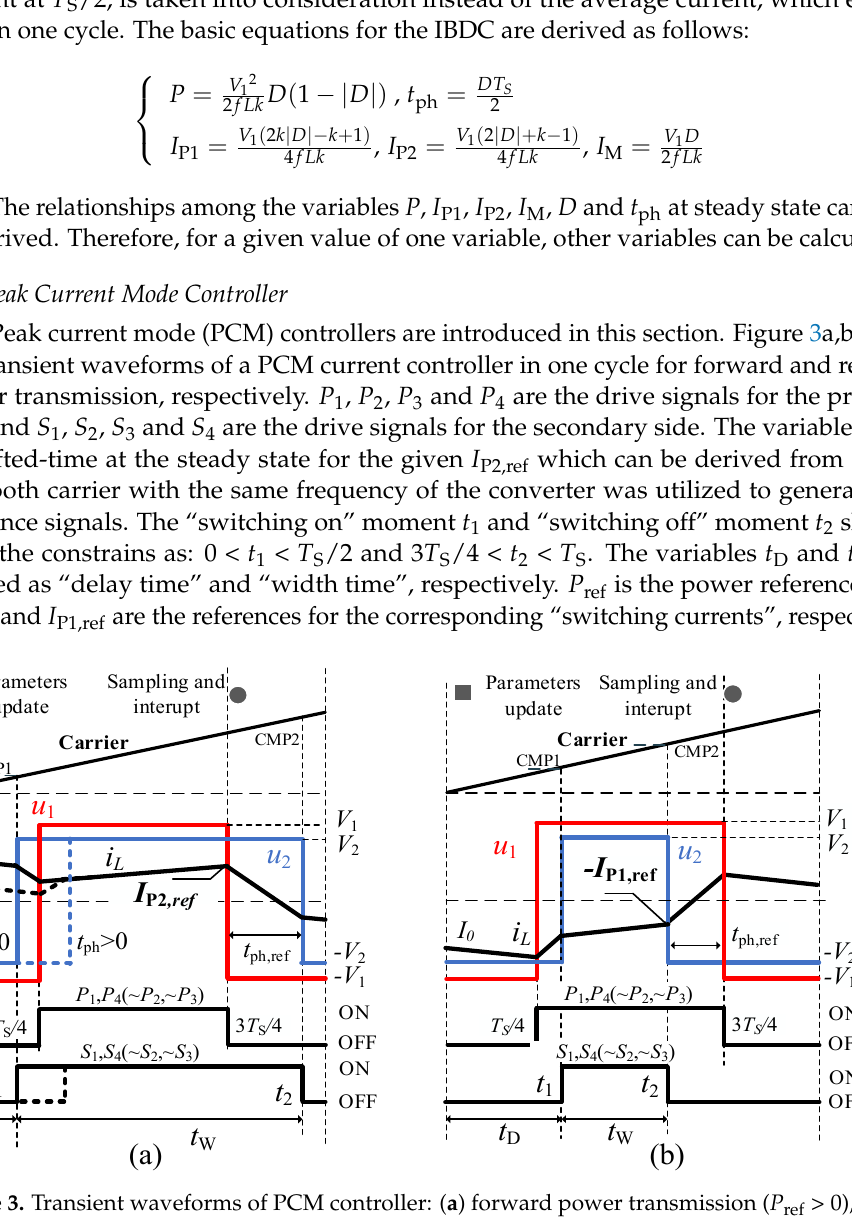
Figure 3. Transient waveforms of PCM controller: ( a ) forward power transmission ( P ref > 0), ( b ) re- verse power transmission ( P ref < 0).